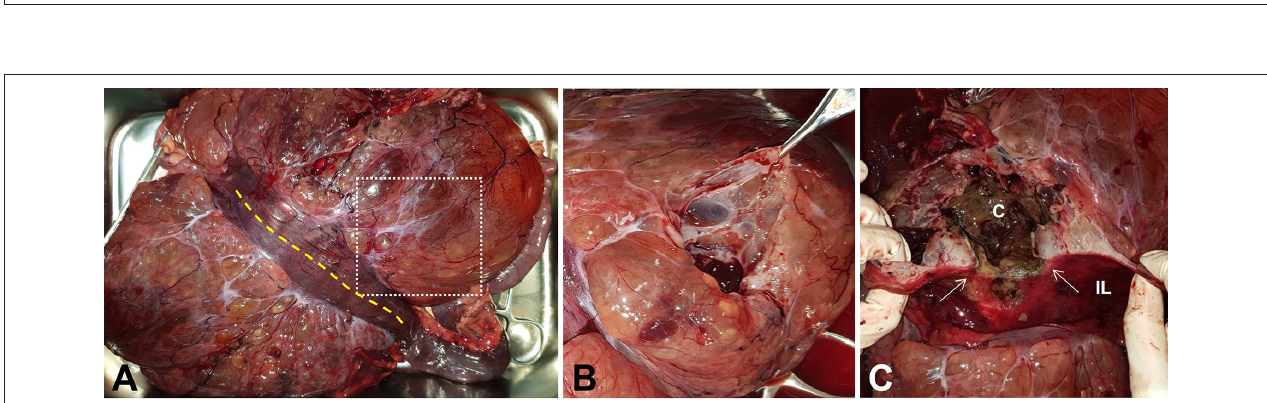
FIGURE 2 | Macroscopic images during surgery. (A) Giant intraperitoneal mass is exposed intraoperatively with adherent jejunum. (B) The giant, multiloculated cystic mass is located at the jejunal mesentery and attached to the mesenteric border of the surrounding jejunal segment (white arrows). (C) The mass and the adhered jejunal segment are completely removed via the jejunal resection and anastomosis.